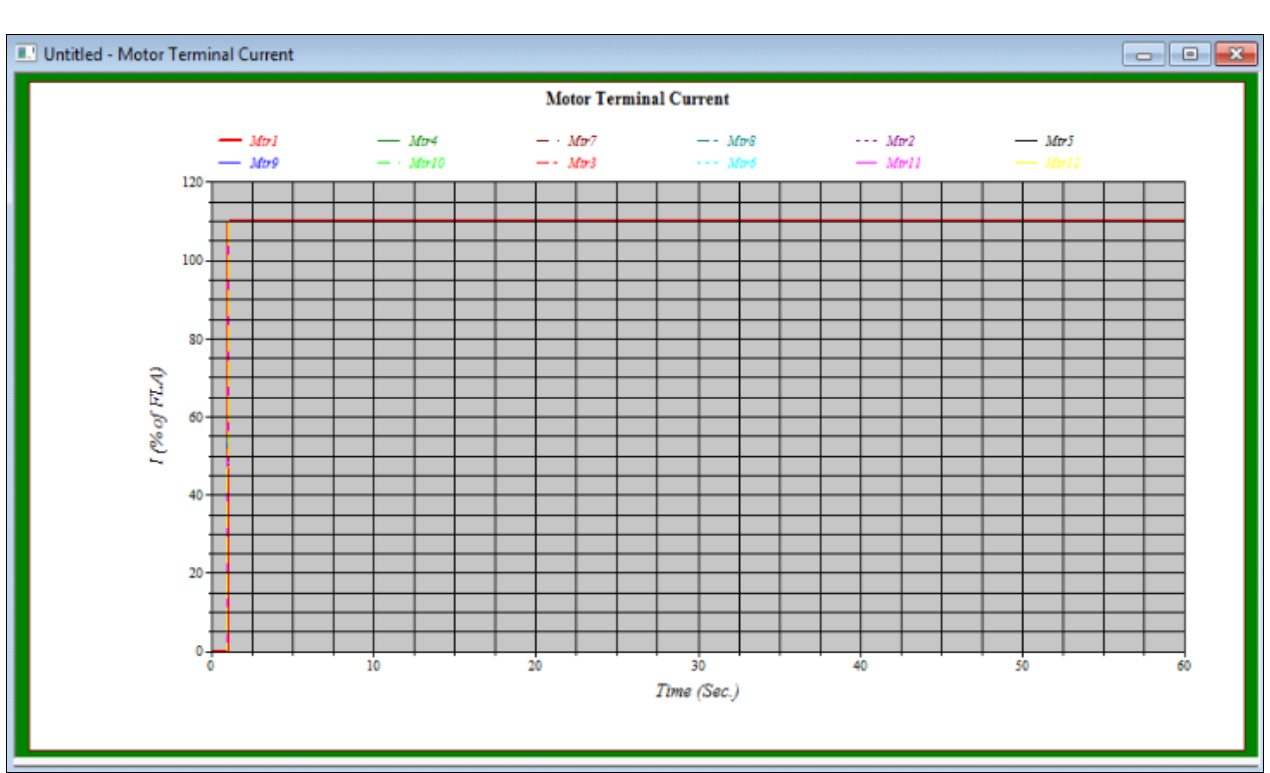
Figure 14: The starting current after insertion of the VFDs. Source: Authors,